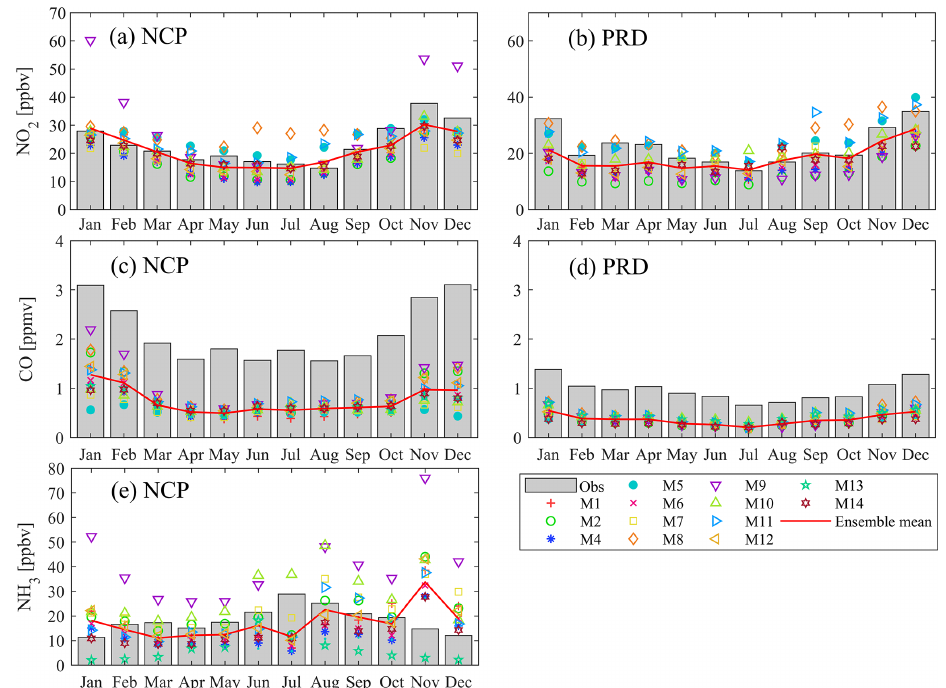
Figure 3. Time series of regional mean NO 2 , CO concentrations over the NCP (a, c) and PRD (b, d) regions, as well as NH 3 concentrations over the NCP (e) region from January to December in the year